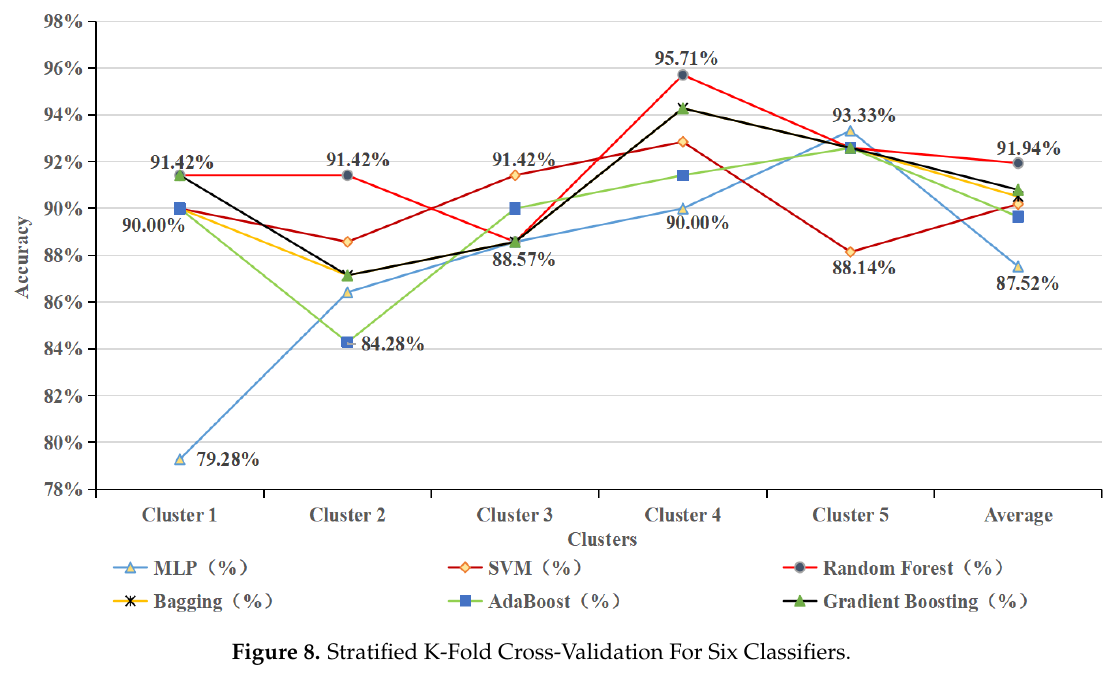
Figure 8. Stratified K-Fold Cross-Validation For Six Classifiers.